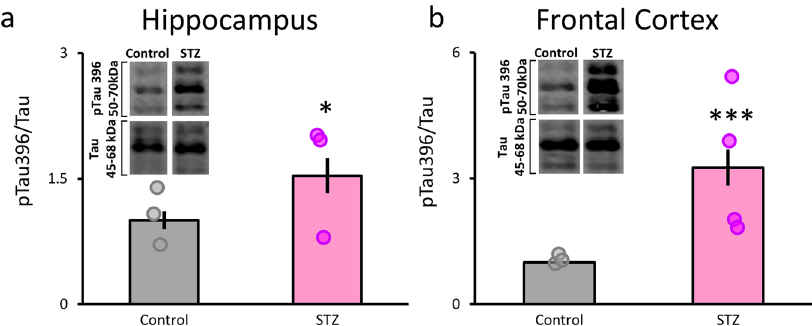
Fig. 6 STZ leads to increased tau phosphorylation in frontal cortex (including ACC) and hippocampus. a , b Tau levels at Ser396 were signi fi cantly elevated in the hippocampus ( a ) and frontal cortex ( b ). Proportions of pTau396 normalized to total tau are on the y -axes. Dots show individual data points (see “ Methods ” ). Saline control values are in gray and STZ in magenta. Representative western blot images are shown in the insets. * p < 0.05; *** p < 0.001. Error bars =